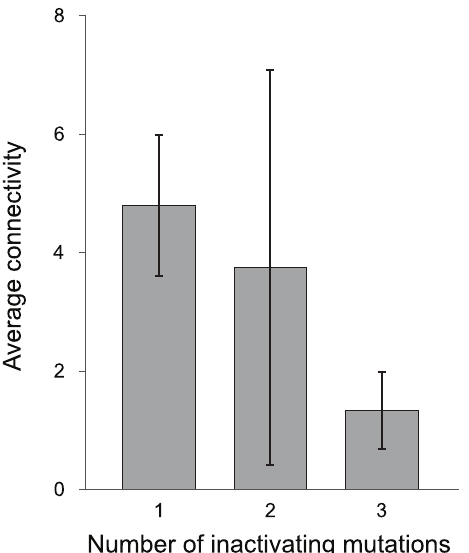
Figure 4. Inferred connectivity of pseudogene homologs in protein–protein interaction networks. The connectivity of each pseudogene was inferred from its functional ortholog in Escherichia coli str. K-12 substr. MG1655 (see Methods). Error bars denote 95% confidence intervals. The difference in number of interacting partners between pseudogenes with a single inactivating mutation and those with three inactivating mutations is statistically significant ( P =0.003, one-tailed unpaired t-test assuming unequal